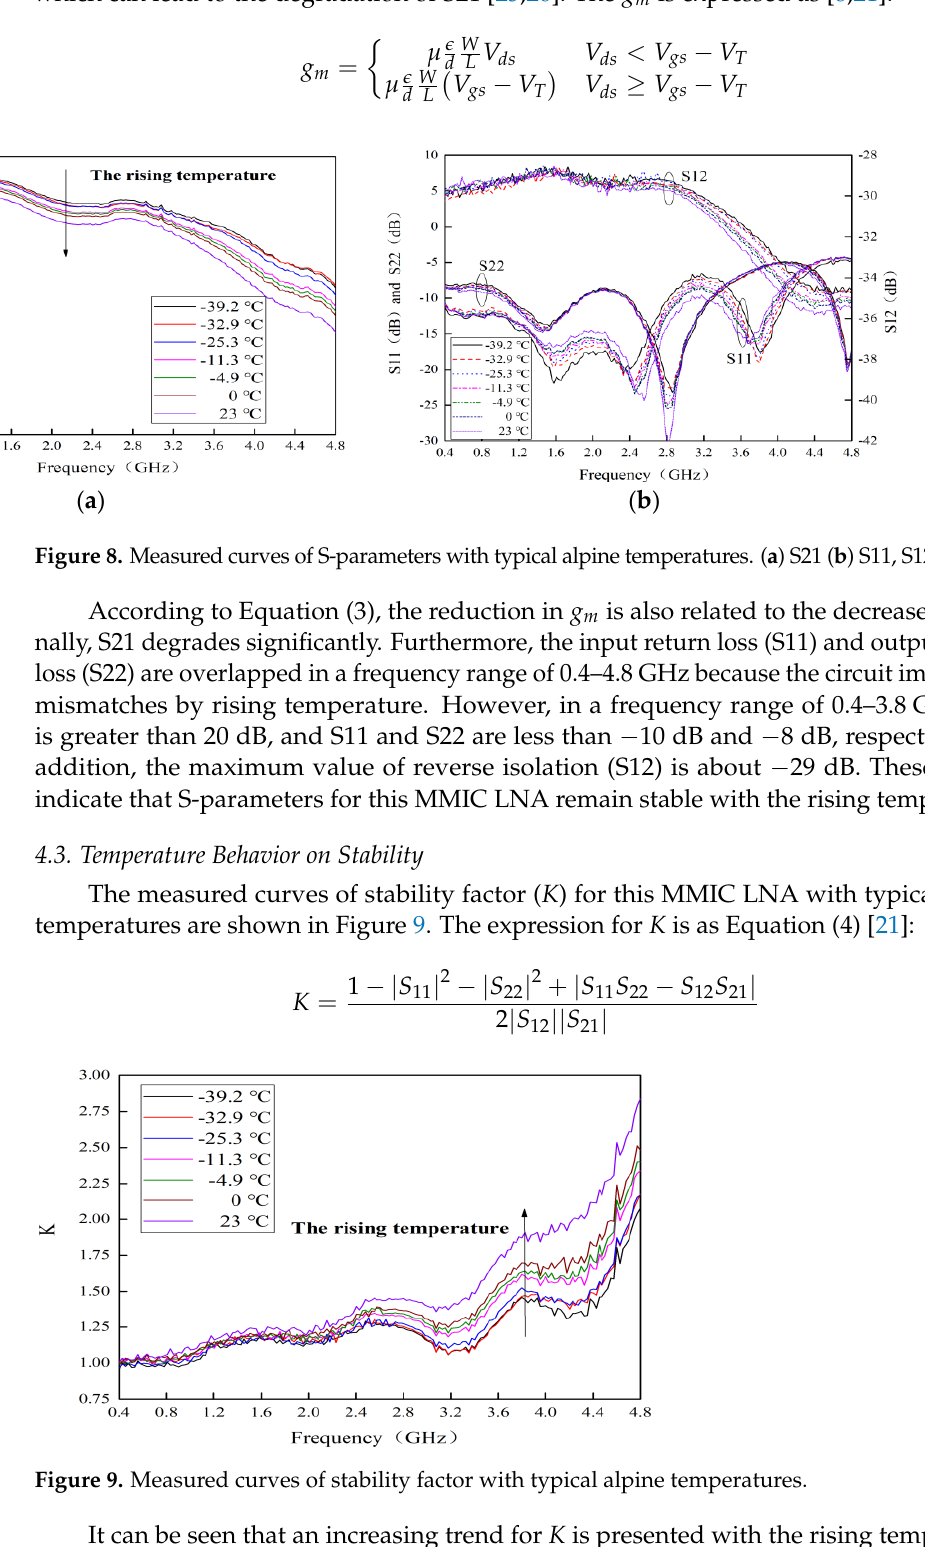
( b ) ( c ) Figure 10. Measured curves of RF output characteristics with typical alpine temperatures. ( a ) 0.4 GHz ( b ) 2.1 GHz ( c ) 3.8 GHz.